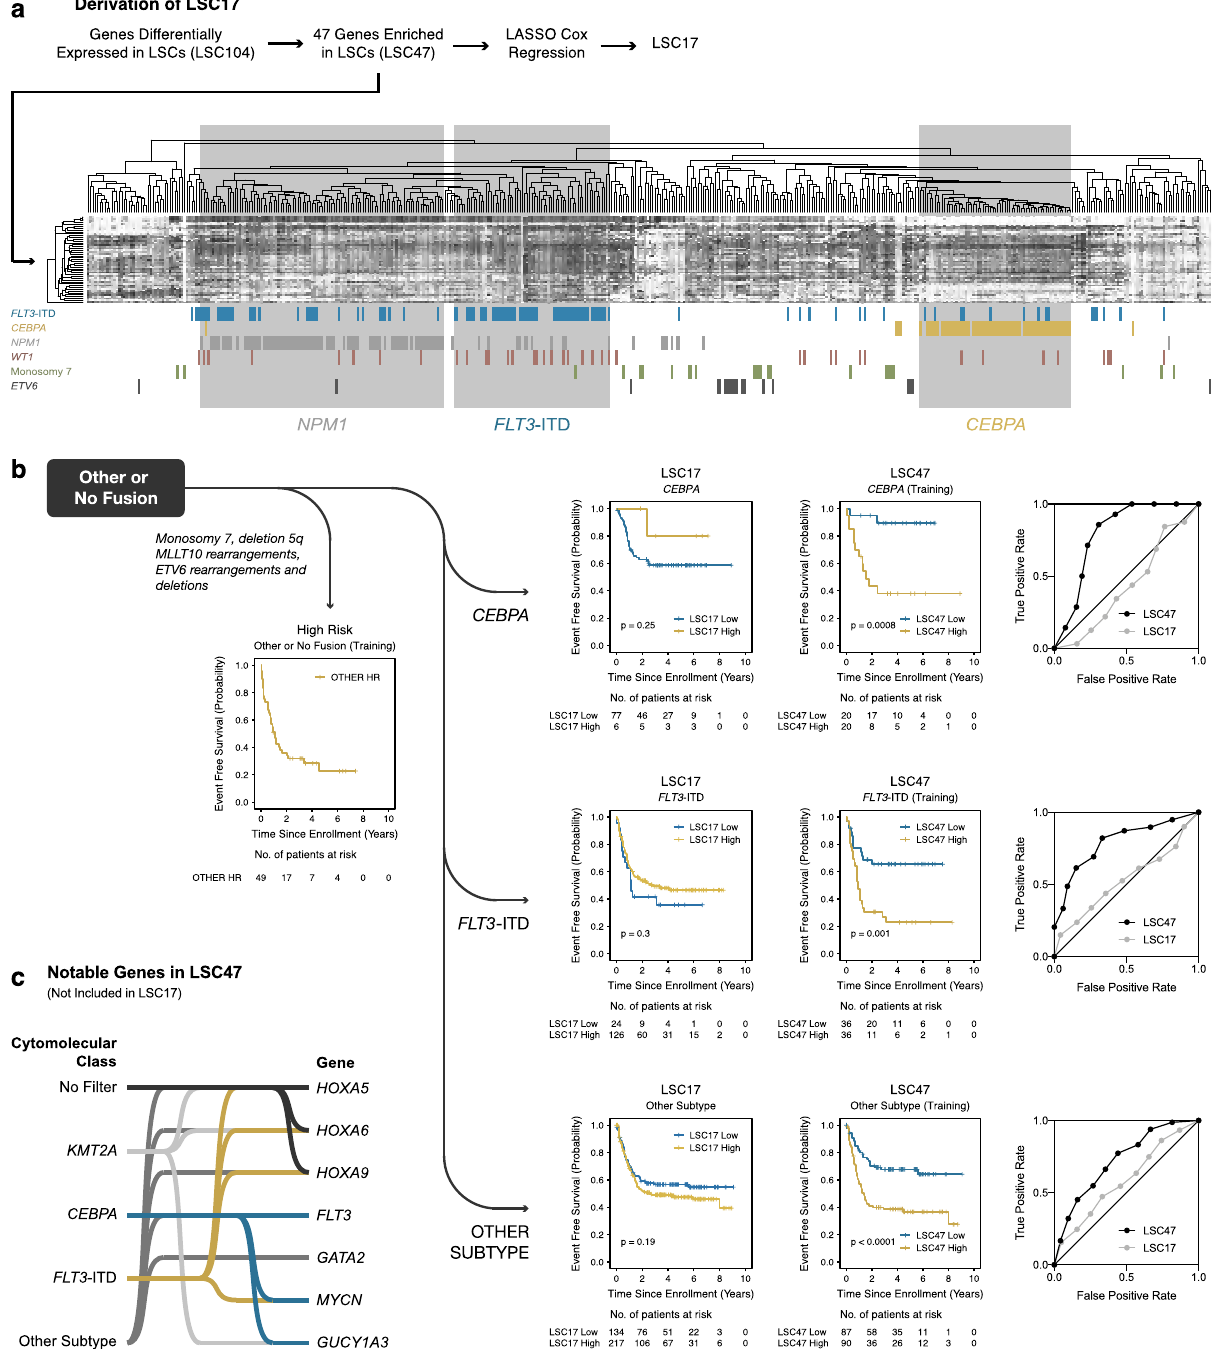
Fig. 4 | Additional transcriptional biomarkers for pediatric AML. a Isolating AMLs that did not have one of the fi ve core fusion alterations, additional cyto- molecularsubtypesclusteredwithoneanotherbasedonLSC47: NPM1 , CEBPA ,and FLT3 internaltandemduplication(ITD)mutation. b Kaplan – Meierestimatesforthe probability of EFS within the training cohort for CEBPA , FLT3 -ITD, and Other